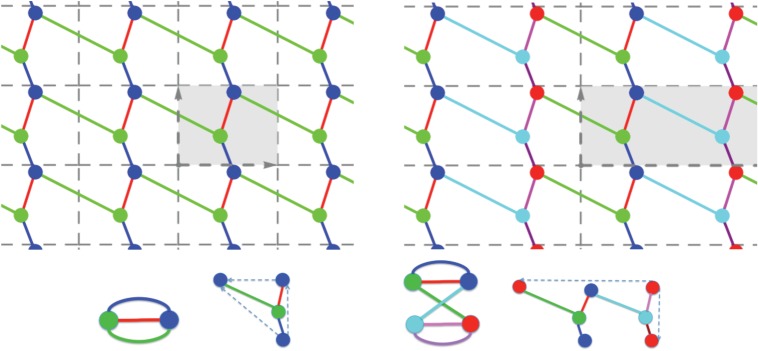
(Top) Two 2-periodic graphs defined on the same infinite graph G and differing by the periodicity group Γ acting on G. Generators of the two lattices and the corresponding unit cells are highlighted, and orbits of vertices and edges are similarly coloured. (Left) For maximal periodicity, there are two vertex orbits and three edge orbits. (Right) With an index two sublattice, there are four vertex orbits and six edge orbits. (Bottom) The corresponding quotient graphs, with matching vertex and edge colours, together with a schematic for the placement of vertex and edge representatives. (Online version in colour.)